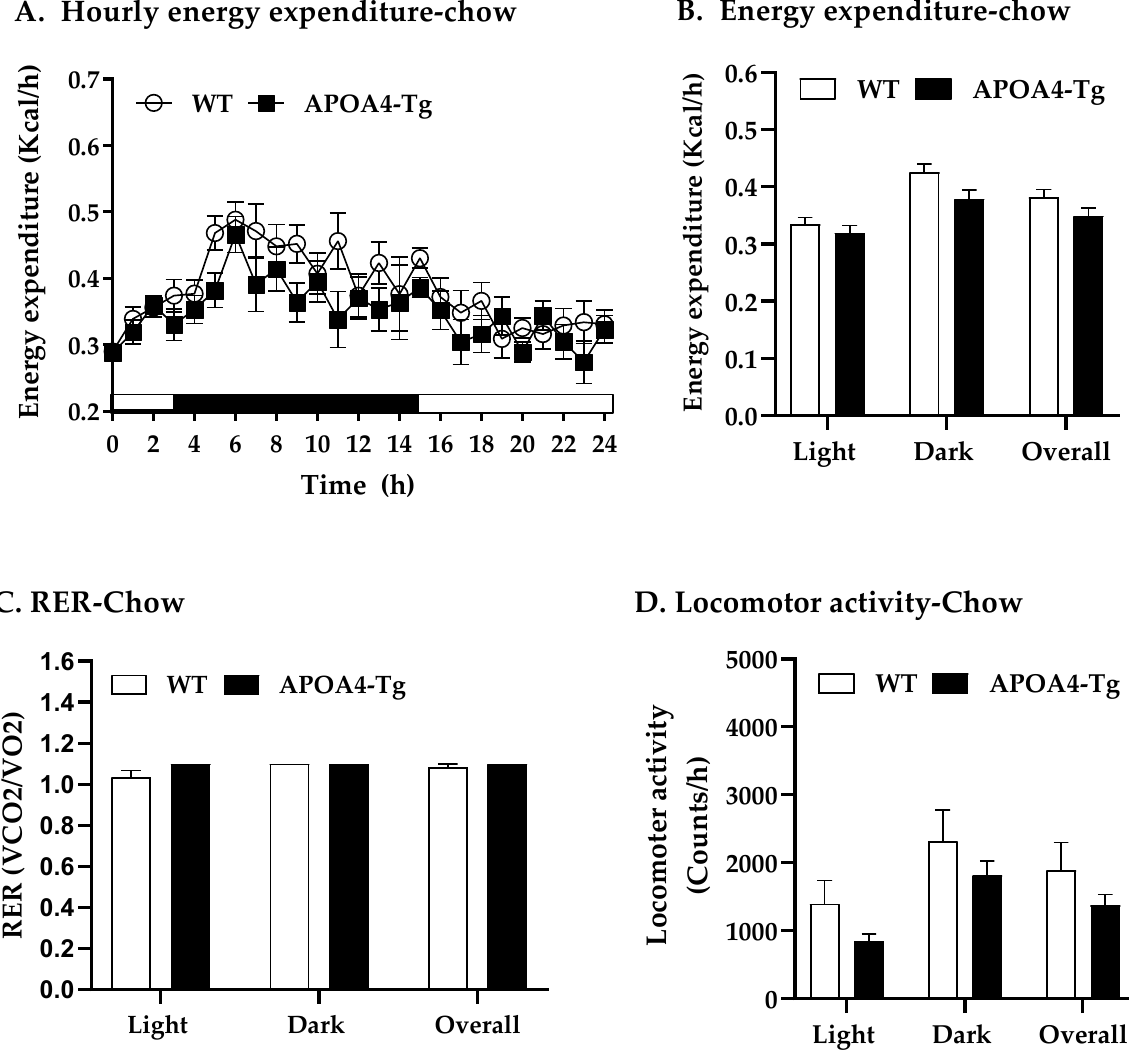
Figure 2. Hourly energy expenditure ( A ), average energy expenditure ( B ), average respiratory exchange ratio (RER, VCO2/VO2) ( C ), and locomotor activity ( D ) during light and dark phases in mice fed a chow diet at 21 °C. Energy expenditure was covaried for lean body mass. Data are expressed as mean ± SEM. n = 8 per group.